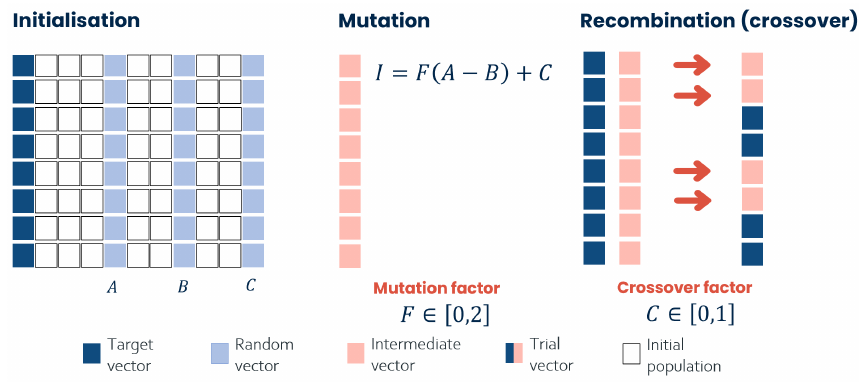
Figure 2. A schematic representation of the Differential Evolution